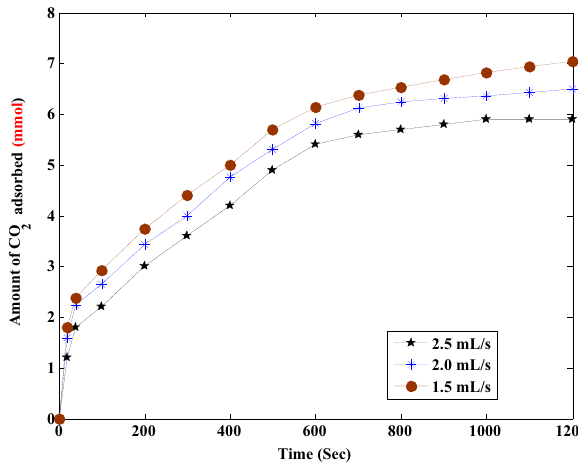
Fig. 5 Effect of operating pressure on the adsorption capacity of polyaspartamide